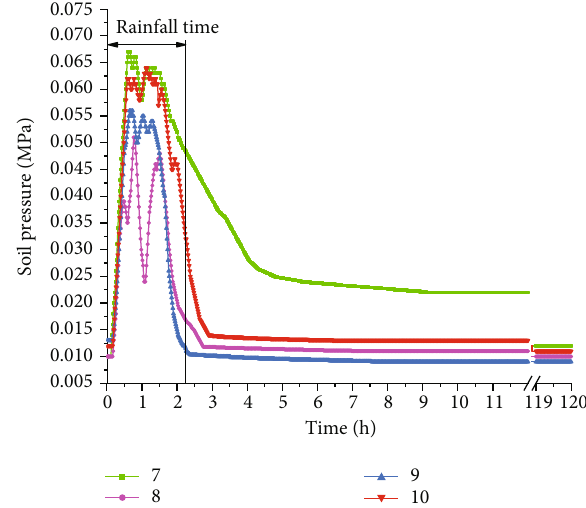
Figure 22: The changes of the soil pressure on the tunnel vault with